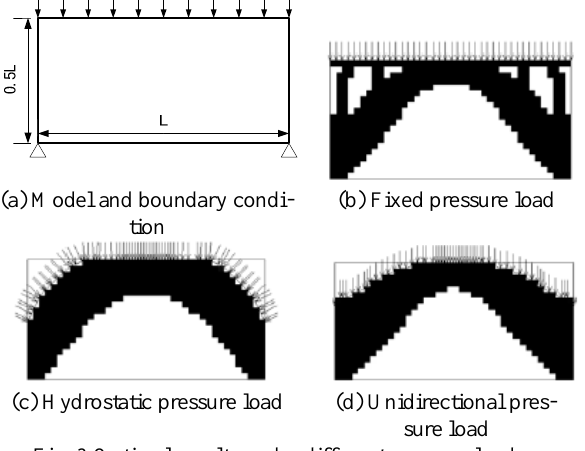
Fig. 3 Optimal results under different pressure loads (Du and Olhoff